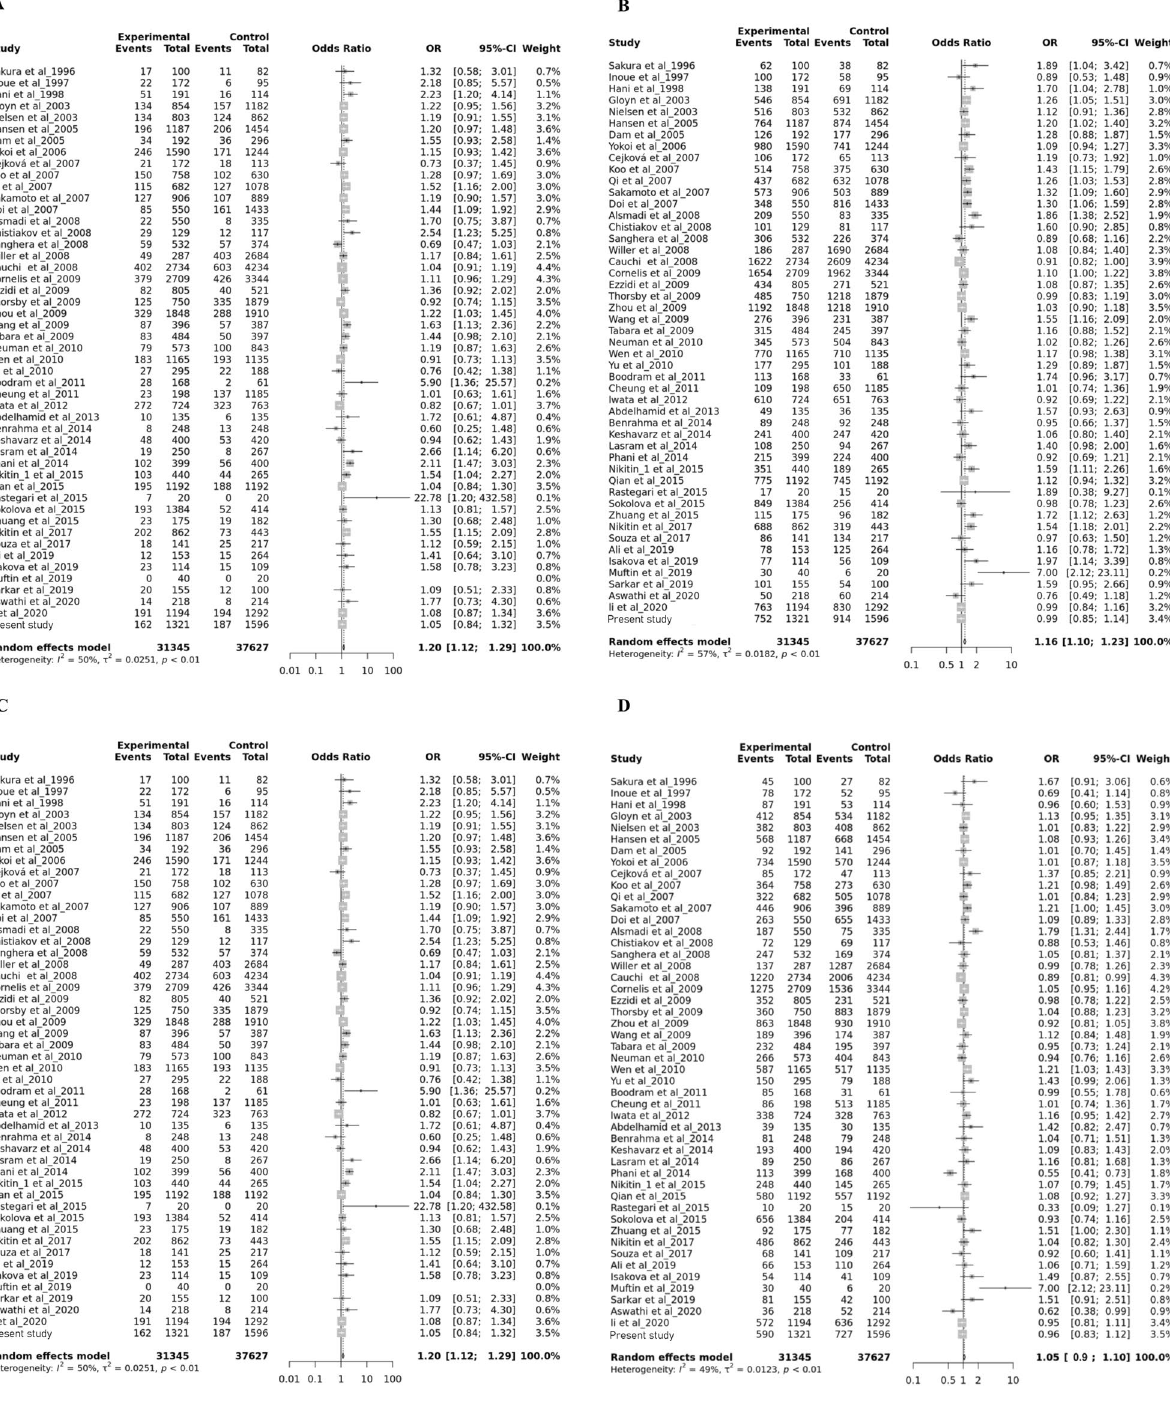
Figure 2. Forest plot for the association between rs5219 and type 2 diabetes risk under different genetic models, allele contrast ( A ), recessive ( B ), dominant ( C ), and over-dominant ( D ). Diamond shows the pooled odds ratio size and its 95%